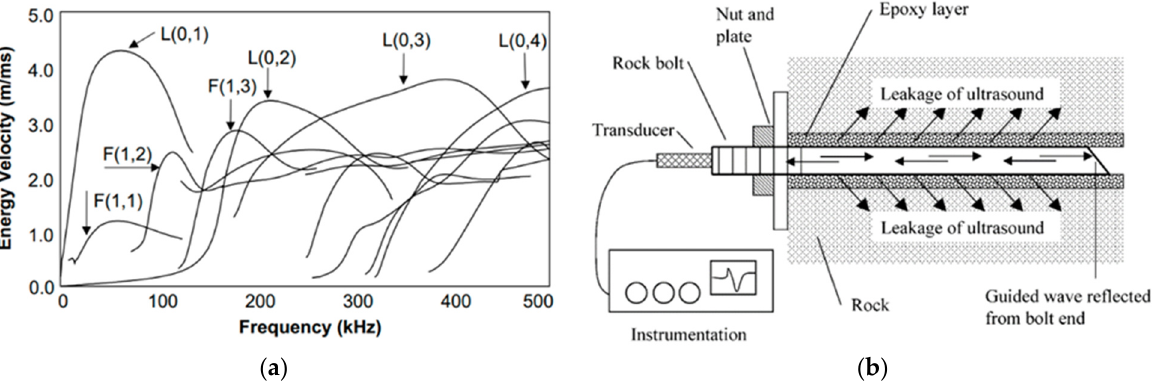
Figure 2. ( a ) an example of energy velocity dispersion curves for the rock bolt model; ( b ) Schematic diagram of the rock bolt installation using guided waves inspection